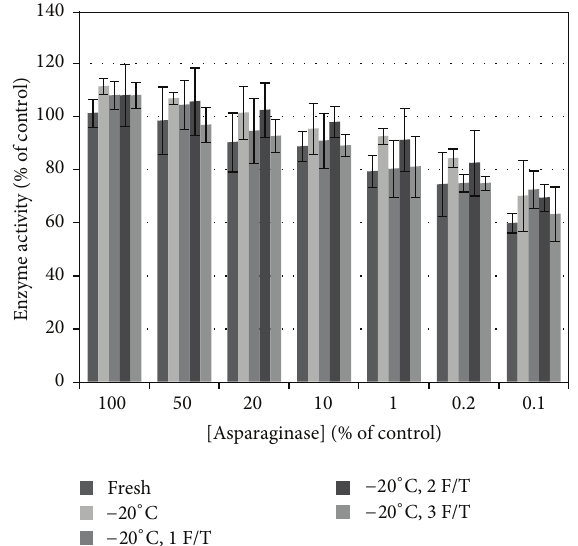
Figure 7: Effect of freezing on asparaginase enzyme activity. Dura- tion of freezing accounts for a minor portion of the statistical dif- ference between cold storage groups. Post hoc tests did not identify a significant difference between either freezing durations compared to control. This verifies that frozen stocks retained enzyme activity up to 6 months similar to freshly prepared drug.